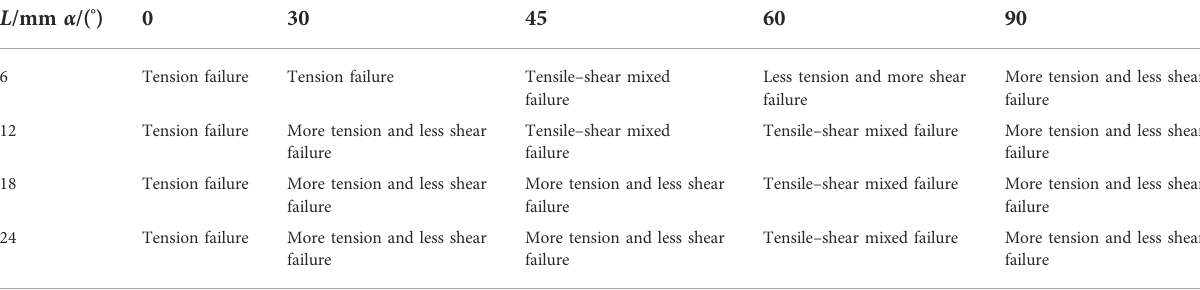
TABLE 4 Failure characteristics and composite rock